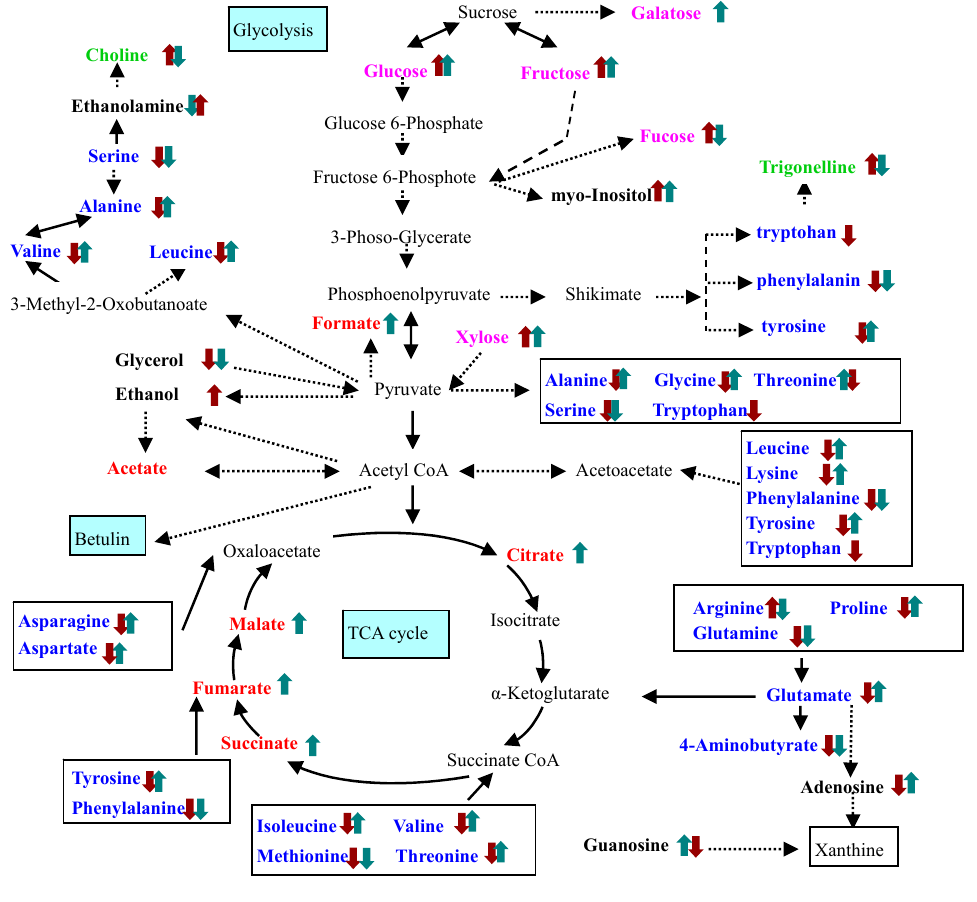
Figure 2. Proposed metabolic pathway alteration in suspension cells of birch induced by NO treatment. Metabolites identified by NMR spectroscopy are depicted in bold (blue amino acids and the derivatives; red Organic acids; pink sugars; green alkaloids; black other metabolites). cPTIO treatment, SNP treatment. Dash arrows skip one or several steps.